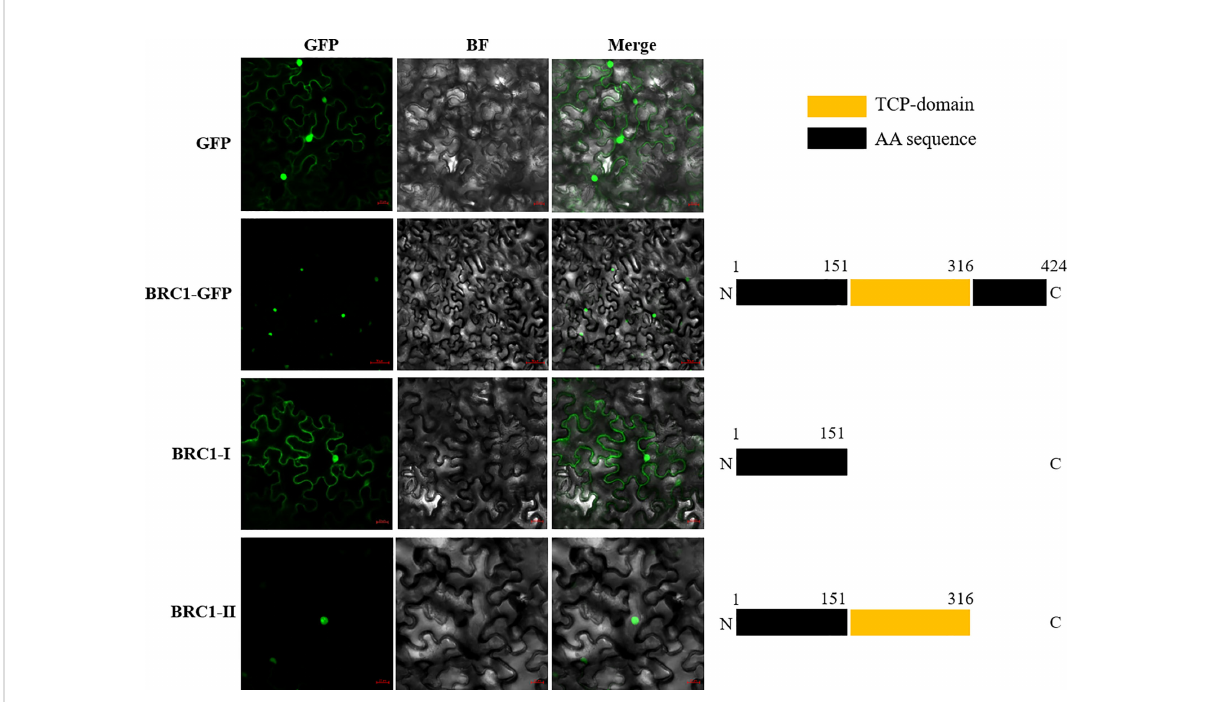
FIGURE 2 The subcellular localization of BjuBRC1-1 protein and its two truncated proteins. The schematic diagram of two truncated proteins is shown on the right. GFP, GFP fl uorescent; BF, bright- fi eld; Merged, merged image of GFP and